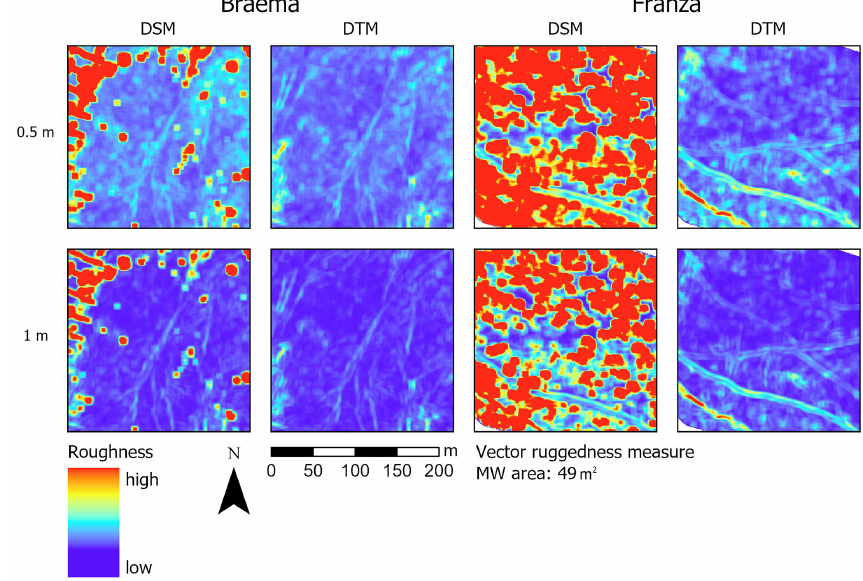
Figure A4. Calculated surface roughness in the two study areas Braema and Franza, using DSM and DTM (© swisstopo for Braema, region Veneto for Franza) and the vector ruggedness measure algorithm.